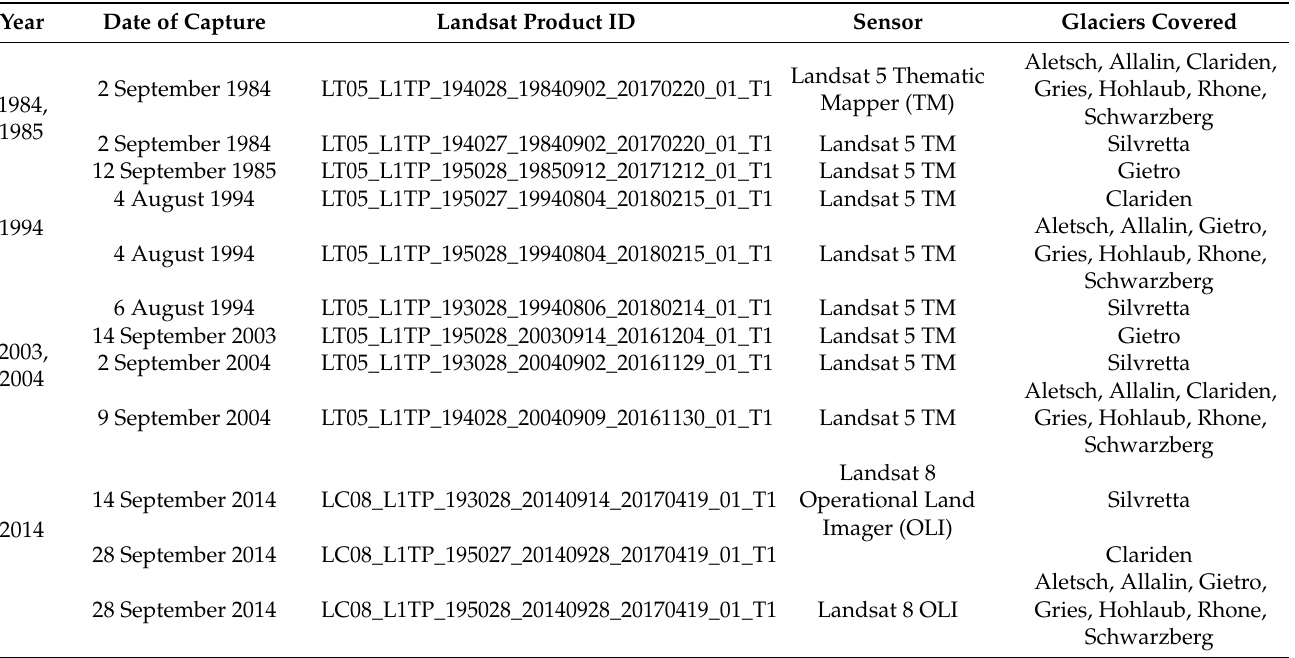
Table 2. Overview of Landsat data used for termini